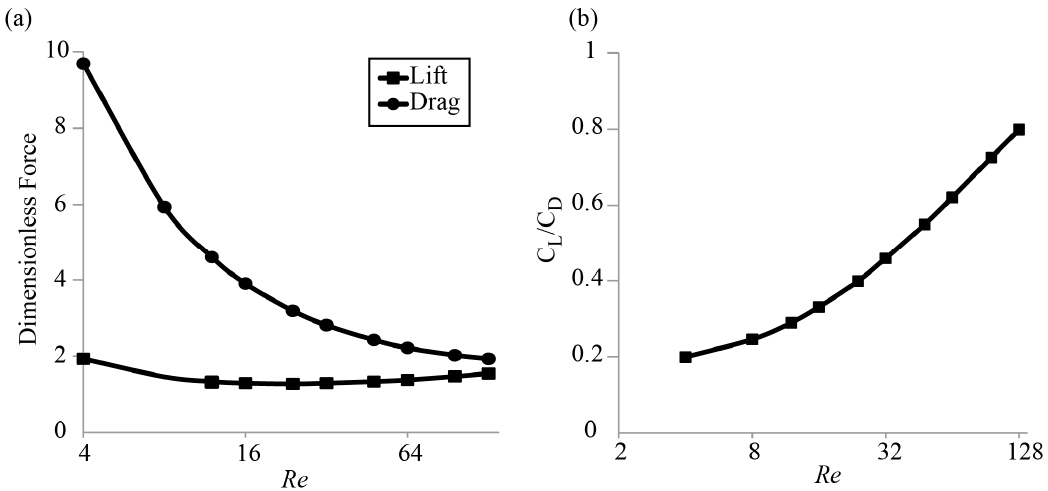
Figure 4. The average ( a ) dimensionless lift (squares) and drag (circles) and ( b ) the ratio of lift to drag over a range of Re (aoa = 45°). These results were obtained from three-dimensional computational simulations.